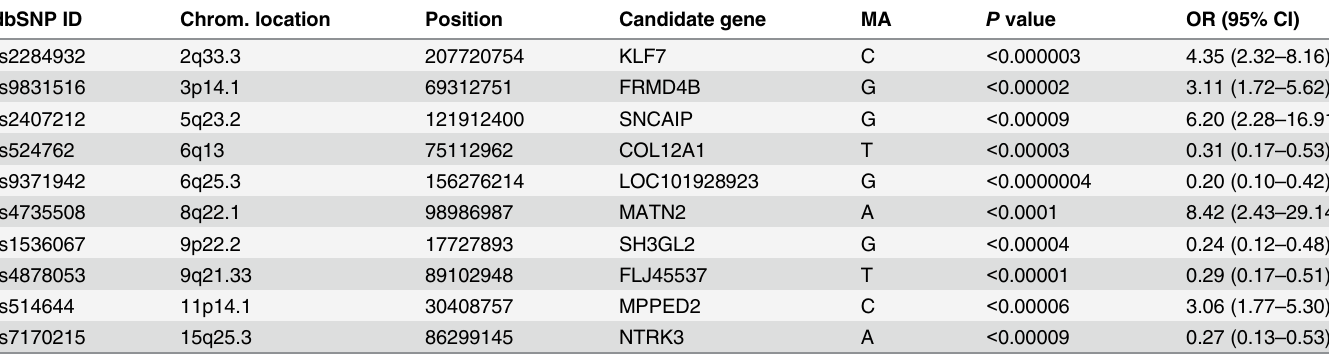
Table 1. Single nucleotide polymorphisms showing the strongest associations (P < 0.0001) in the genome-wide association study. dbSNP